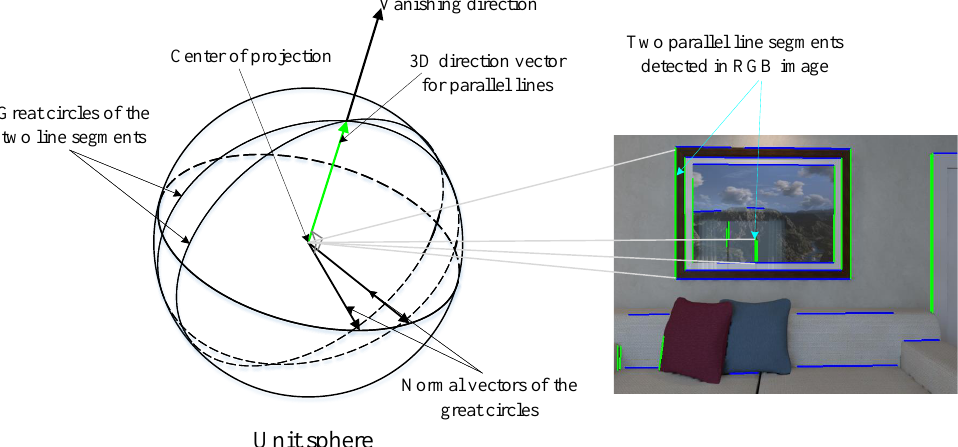
Figure 5. Three-dimensional geometric relationship between parallel lines and their vanishing direction. The unit sphere is in the center of a camera projection. Two parallel lines are projected onto the unit sphere as two great circles, and the vanishing direction is obtained by the cross-projection of these two great circles’ normal vectors. Two parallel lines and their corresponding vanishing direction are drawn in